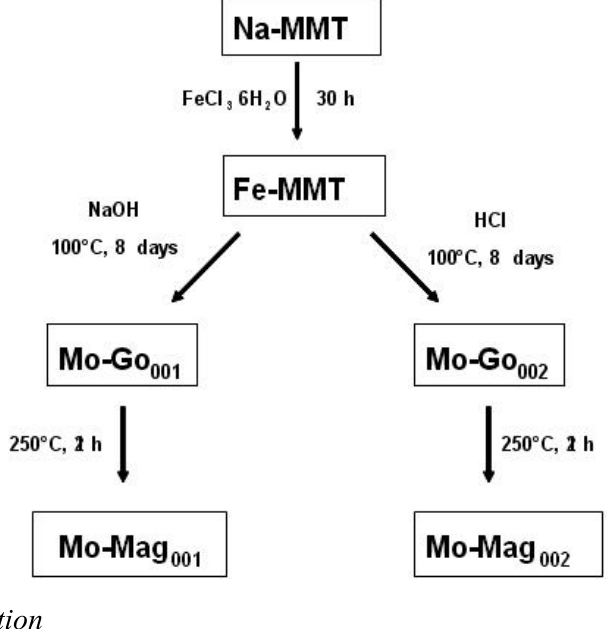
and Mo-Mag 001 002